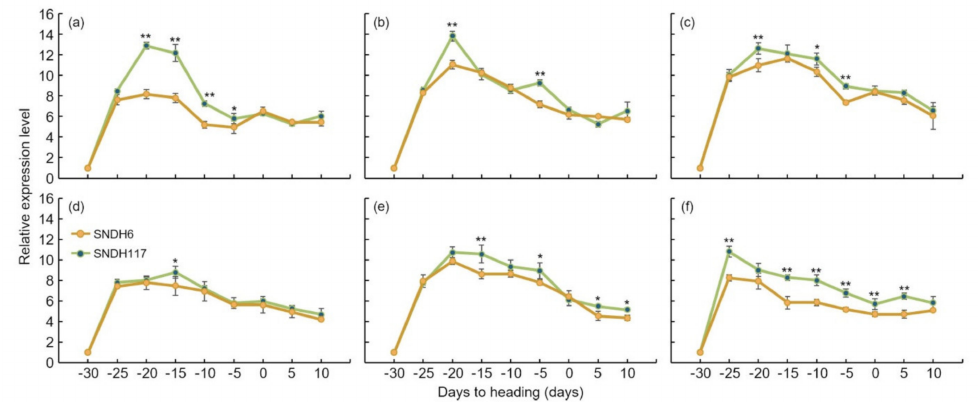
Figure 7. Analysis of the relative expression level of candidate genes related to grain size at the spikelet differentiation stage. Relative expression levels were analyzed at intervals of 5 days from 30 days before heading to 10 days after heading. The panicle formation stage starts from 30 days before heading, and grain size is determined at this time. The relative expression levels of candidate genes were analyzed in SNDH6 and SNDH117. * significant at the 0.05 level; ** significant at the 0.01 level. ( a ) OsBRKq1 , ( b ) LOC_Os01g48444 , ( c ) LOC_Os01g53880 , ( d ) LOC_Os01g61690 , ( e ) LOC_Os02g42310 , and ( f ) LOC_Os02g46260 .